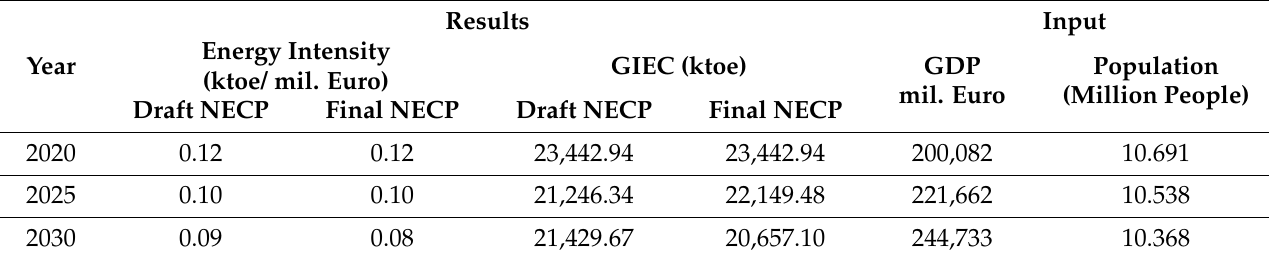
Table 2. Gross Domestic product (GDP) and population projections considered in the present study for simulating the economic and societal impact of the targets set under the draft and final versions of the Greek NECP. These variables were also the exogenous parameters of the energy models used for preparing the NECPs and estimating the evolution of energy intensity and gross inland energy consumption (GIEC)